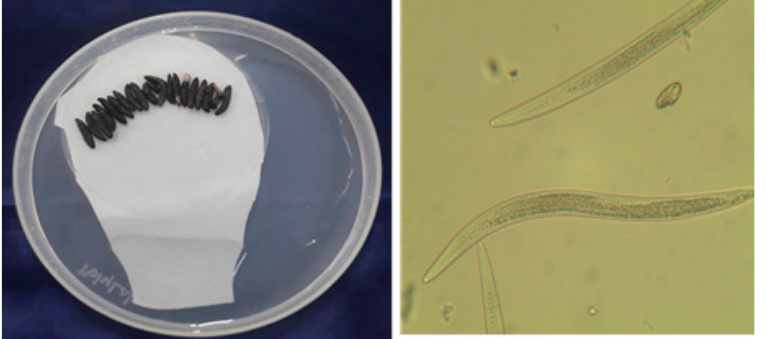
Fig. 3 Entomopathogenic Nematode infected Galleria mellonella and its morphological characterization of Steinernema